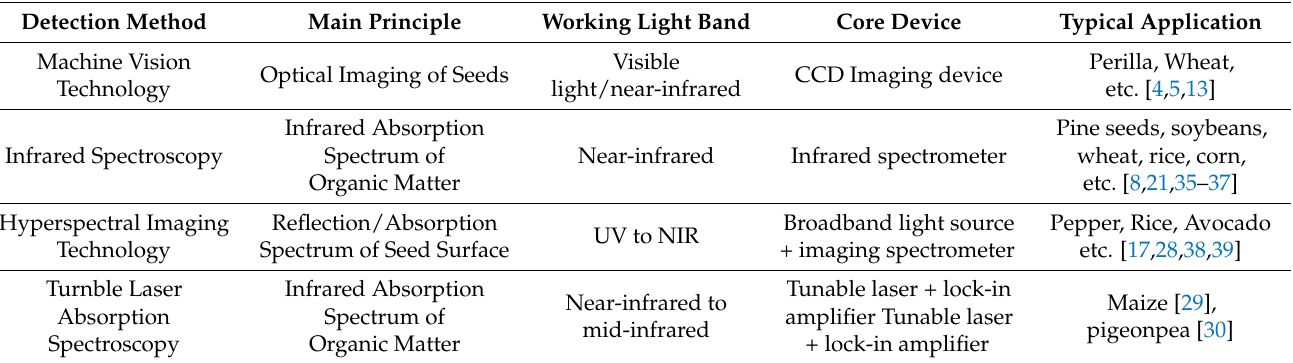
Table 1. Current research developments of seed vigor detection procedures using modern optical